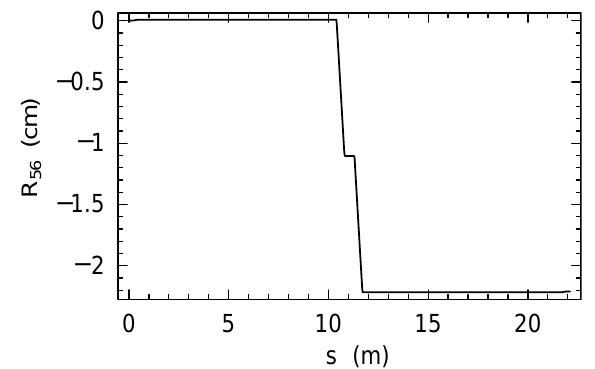
FIG. 2. Plot of the dispersion function for the LCLS bunch